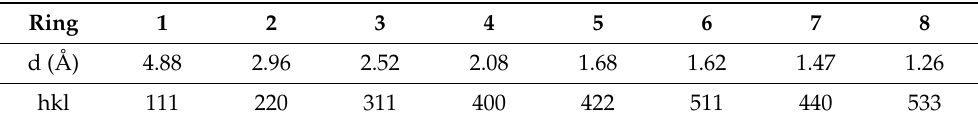
Figure 2. Structural and morphological characterisation of IO-NPs. ( A ) High-resolution transmission electron microscopy (HR-TEM) micrographs of IO-NPs and ( B ) a magnified view of a single NP. ( C ) Selected area electron diffraction (SAED) pattern acquired from an IO-NP assembly. Table 1. Measured lattice spacing, d (angstroms), based on the rings from the selected area electron diffraction (SAED) pattern in Figure 2C, along with their respective hkl miller indices.